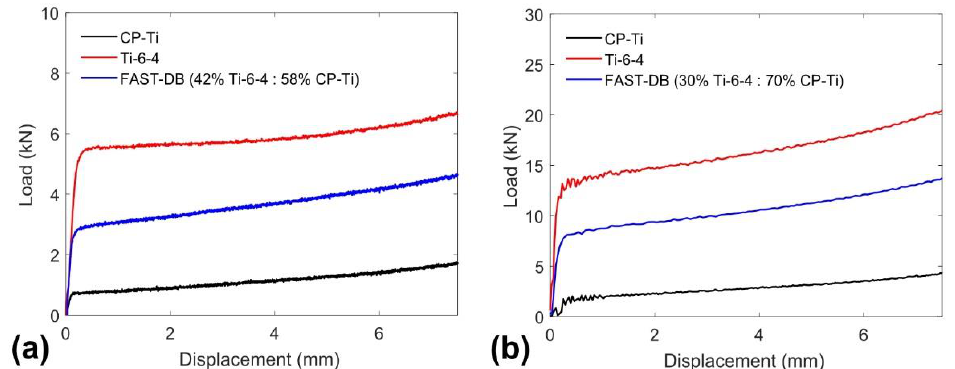
Figure 7. Friction corrected load-displacement graphs comparing single alloy compressions with FAST-DB dissimilar alloy samples at a test temperature of 950 °C and a constant strain rate of; ( a ) 0.1 s − 1 ; and ( b ) 10 s − 1 .